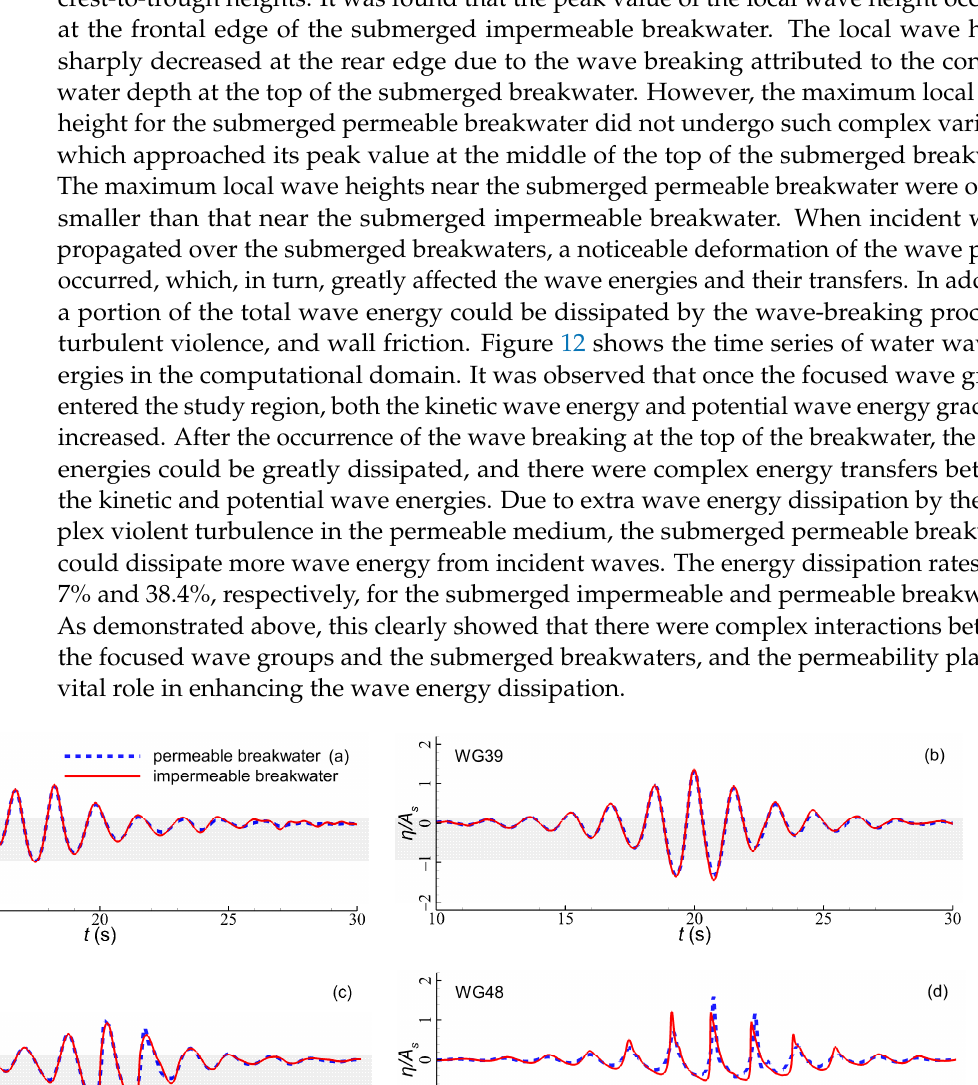
Figure 8. Snapshots of the water velocity contours at different times; left side ( a – d ): submerged impermeable breakwater; right side ( e – h ): submerged permeable breakwater